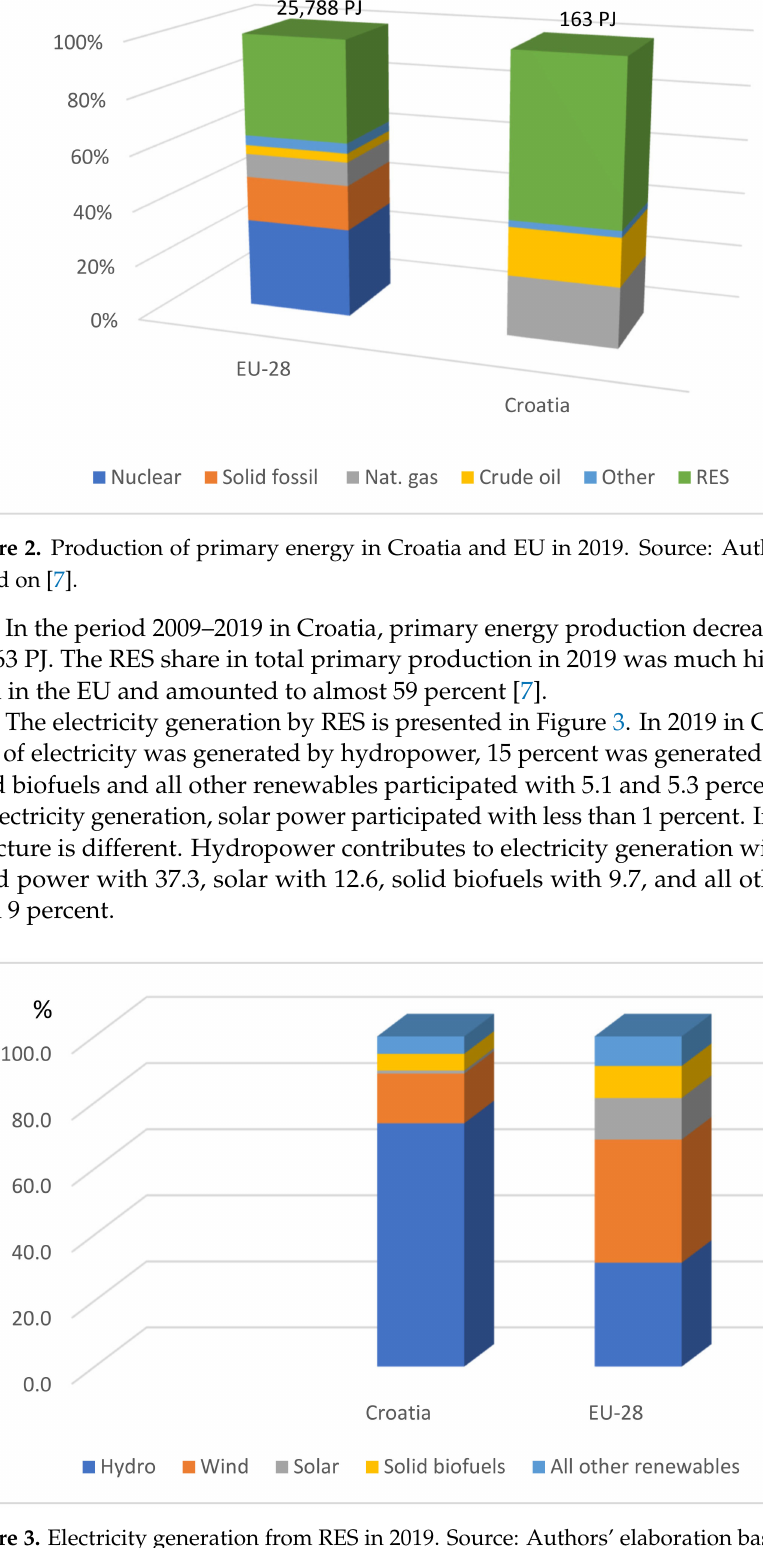
Figure 3. Electricity generation from RES in 2019. Source: Authors’ elaboration based on